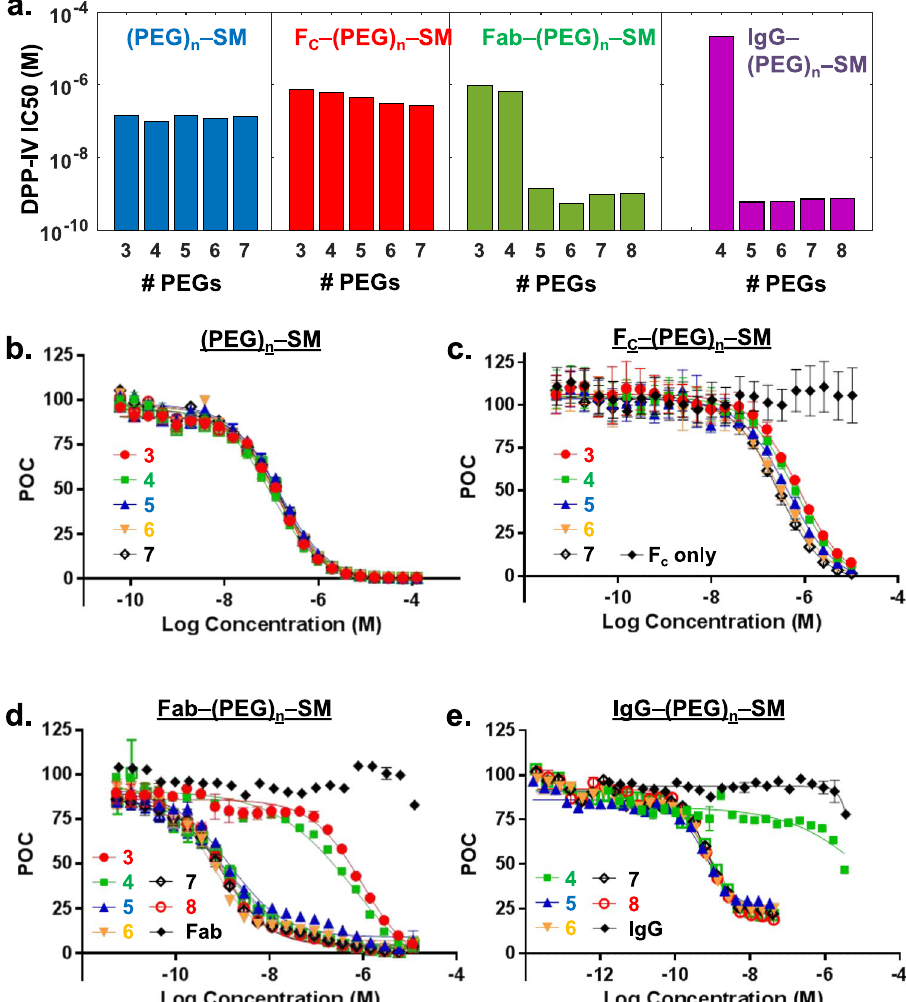
Figure 3. Biochemical assay results. ( a ) Measured DPP-IV IC50 ′ s for small molecule (SM) inhibitor conjugated to PEG linkers with variable numbers of ethylene oxide units ( 6 with n = 3–7), through PEG linkers to F c ( 9 with n = 3–7), through PEG linkers to N30C of 11A19 Fab ( 8 with n = 3–8), and through PEG linkers to N30C of 11A19 mAb ( 7 with n = 3–8). ( b – e ) IC 50 curves corresponding to the molecules in panel (a). Y-axis label POC stands for Percent of control with 100% being cleavage of the dipeptide substrate with no inhibitor added and 0% being full inhibition. All measurements were done in triplicate and error bars are provided for ( b – e ). Note only some error bars are noticeable due to very tight assay results. Data for additional molecules with longer PEG linkers are provided in the Supplemental